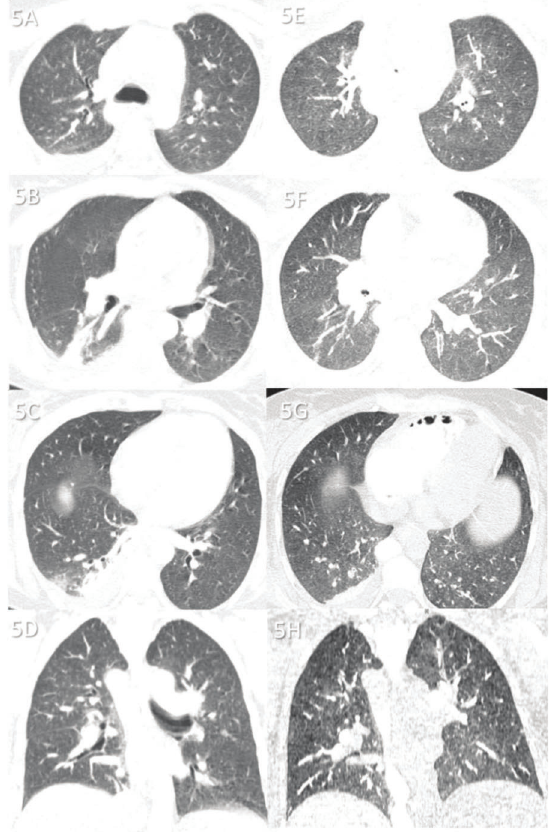
Figure 5 - Case 5: Premortem axial chest computed tomography (CT) of the upper (A), mid (B), and inferior (C) thirds of the lungs obtained 2 days before death showing a few abnormalities, including a small peripheral and posterior ground-glass opacity in the lower right lobe (C), a small atelectasis in the posterior and medial aspects of the same lobe, and a right pleural effusion. Postmortem axial chest CT of the upper (E), mid (F), and inferior (G) thirds of the lungs obtained 16 h 13 min after death showing findings similar to premortem CT findings, except for a diffuse and subtle increase in attenuation of the lungs and thinning of the atelectasis in the right inferior lobe—changes probably because of the expired lungs during postmortem CT. The ground-glass opacity in the small right inferior lobe is not observed on postmortem CT, and the right pleural effusion is stable. Images D and H show pre- and postmortem coronal reformats, respectively. This patient died from liver transplant complications. Pre- and postmortem chest CT showing a normal lung parenchyma, indicating that she died with COVID-19, not from COVID-19.